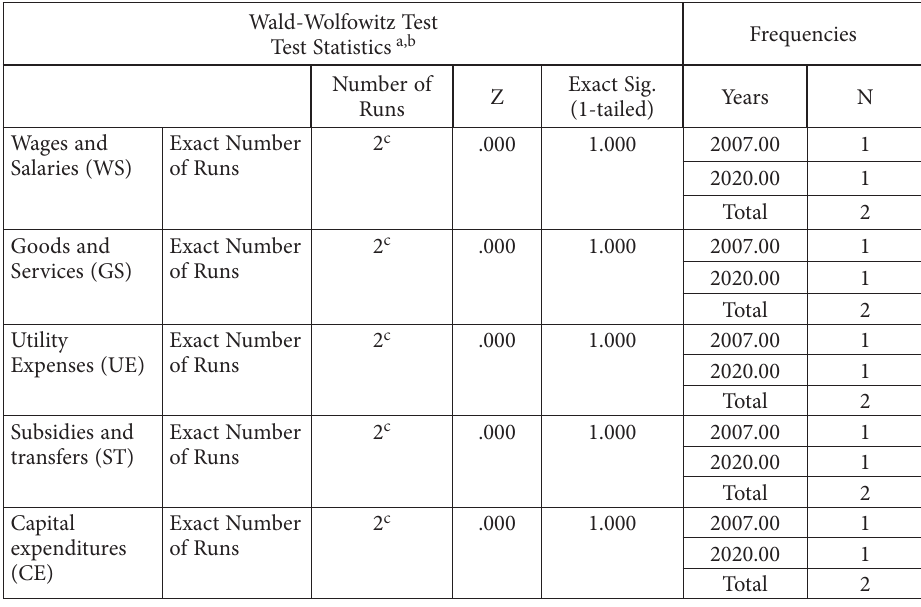
Frequencies Years N